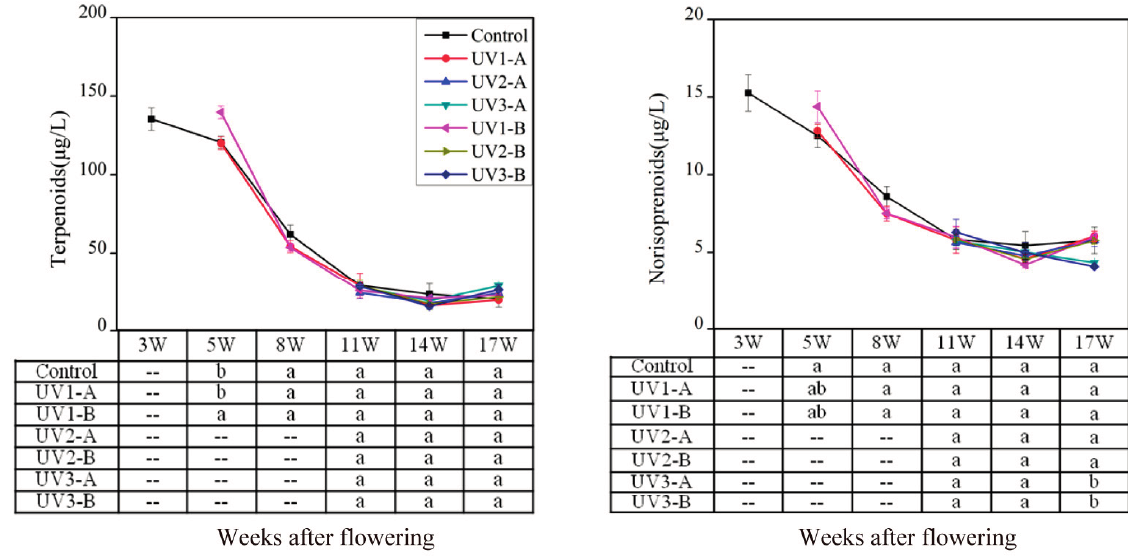
Figure 3. Effect of the attenuated UV radiation on the concentration of terpenes and norisoprenoids in developing “Cabernet Sauvignon” grapes. For more information, please refer to the explanation in Figure